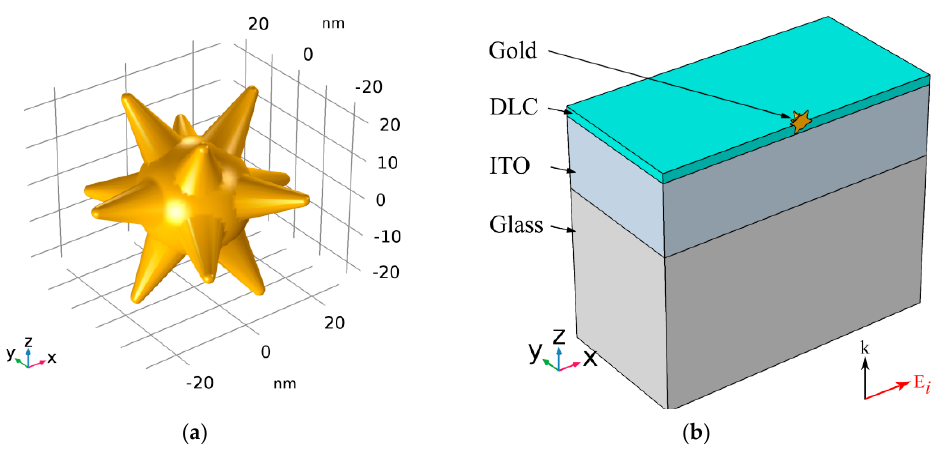
Figure 3. Geometric model of a nanostar ( a ) and a schematic representation of the computational domain ( b ) for finite element modeling of a nanostar embedded into a DLC film.